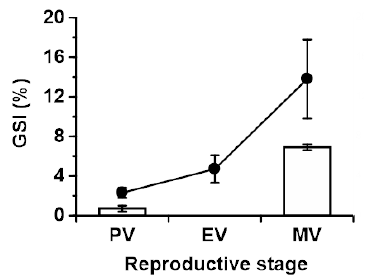
Figure 1. Gonadosomatic index (GSI) of artificially maturing Japanese eels (black circles) and in wild-caught longfin eels (white columns) during vitellogenesis. Ovarian development was classified as: previtellogenic (PV), for follicles < 200 μ m in diameter (Japanese eel n = 5, longfin eel n = 9); early vitellogenic (EV) for follicles of 200–400 μ m (Japanese eel n = 8); midvitellogenic (MV) for follicles of 400–600 µ m (Japanese eel n = 10, longfin eel n = 16). Values represent mean ± SEM.